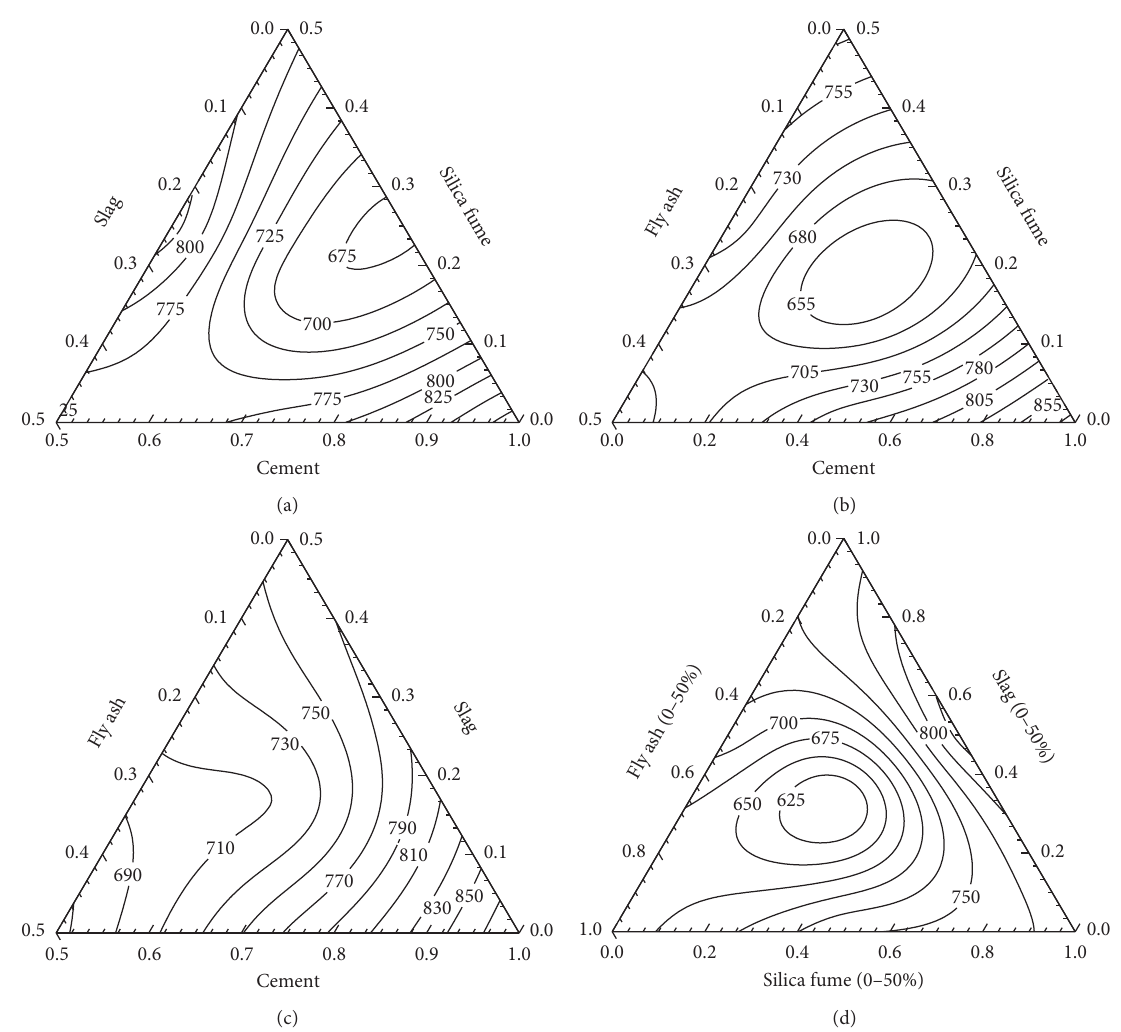
Figure 8: Dry shrinkage of UHPC (28 d) with cementitious system of cement-silica fume-slag-fly ash